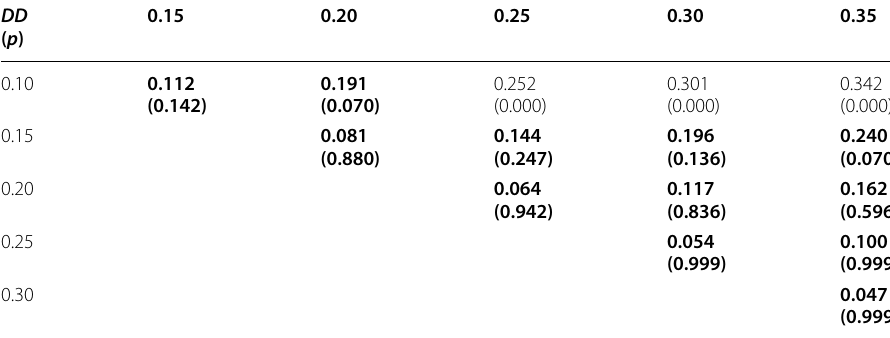
Table 5 Robustness results in CSI 300